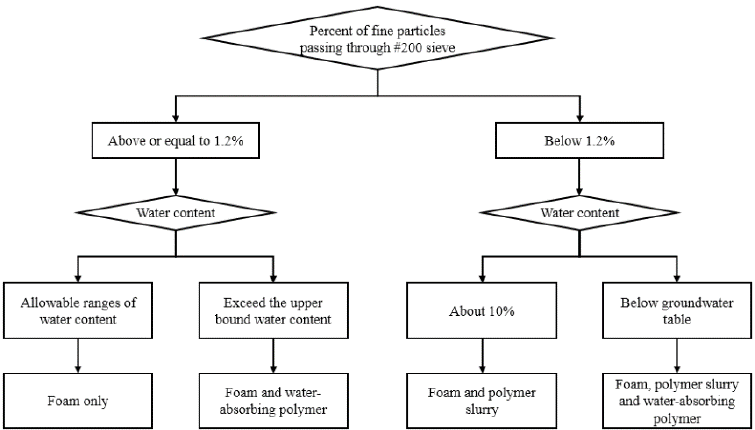
Figure 11. Soil conditioning agent selection for EPB shield TBM in weathered granite soil.